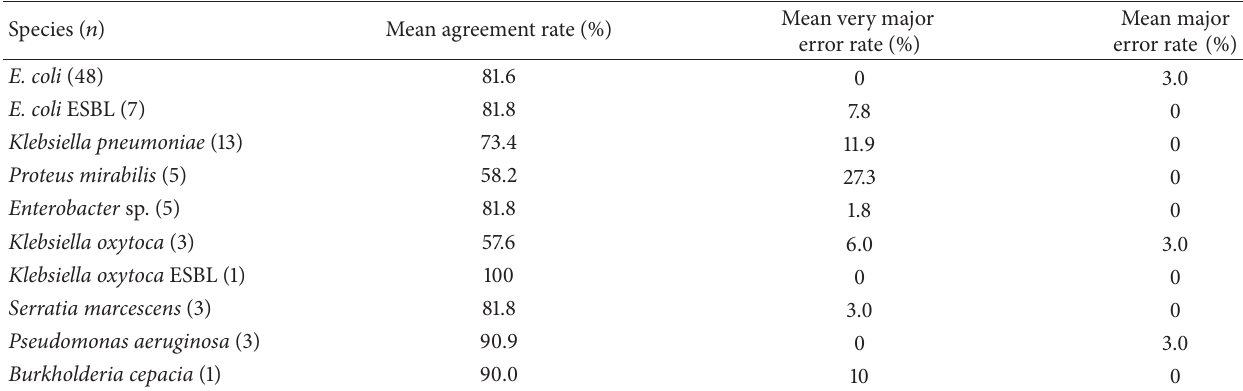
Table 3: Agreement between direct and standard susceptibility by